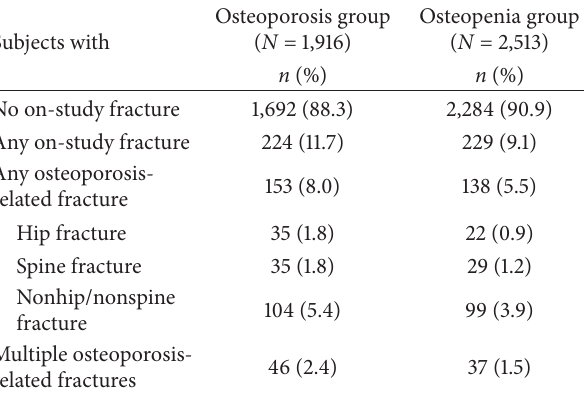
Figure 1: Percentage of subjects with osteoporosis or osteopenia by number of fracture risk factors. Table 1: Subject-reported on-study